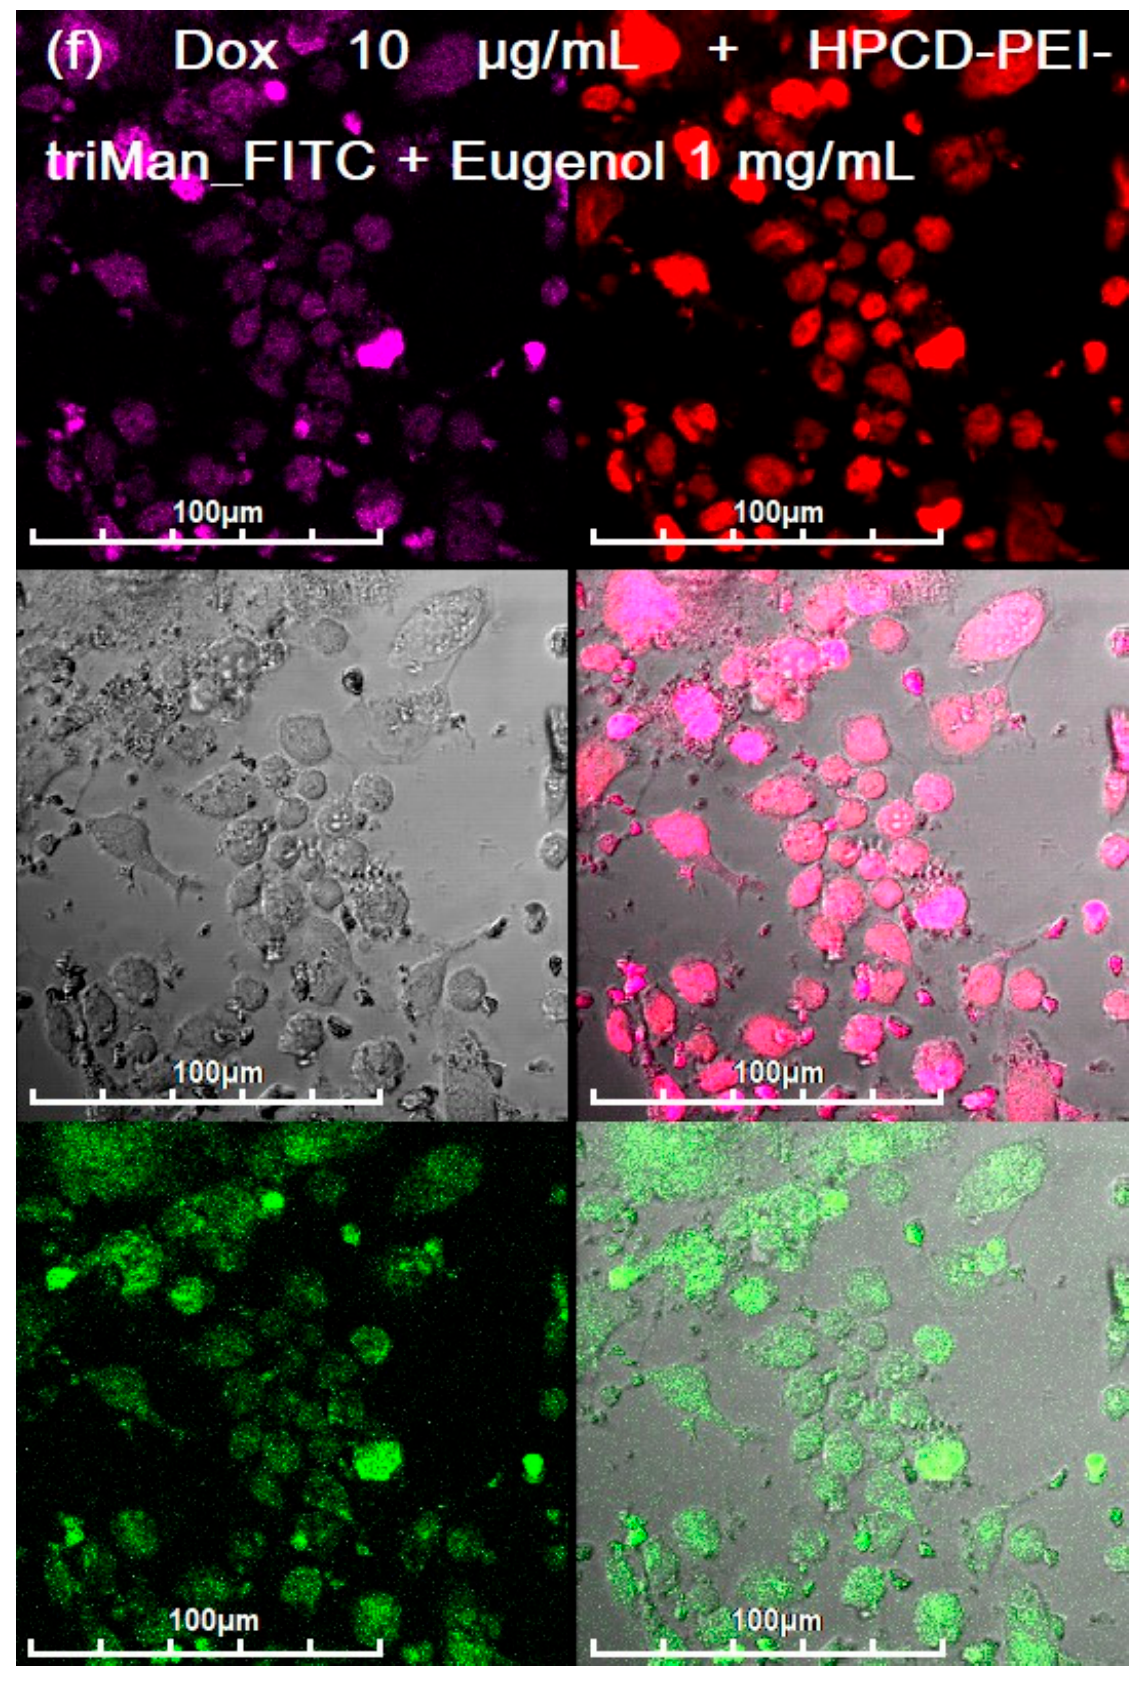
Figure 5. Confocal laser scanning images of CD206+ macrophages with absorbed eosin-labelled E. coli . Incubation 2 h with Dox 10 μ g/mL and FITC-labeled HPCD-PEI1.8. Dox 10 μ g/mL: (a) free, (b)